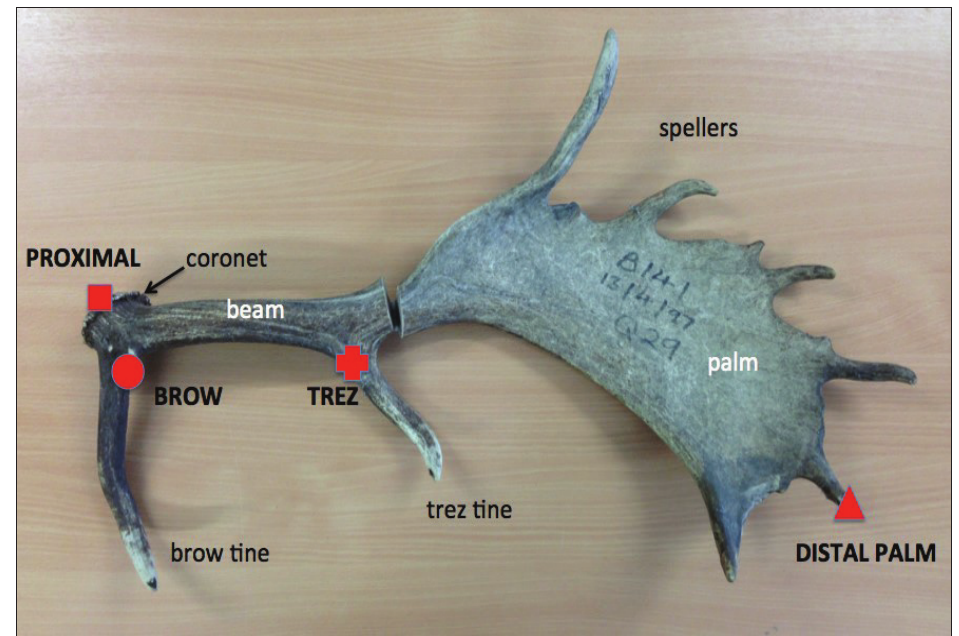
Figure 1: Sample locations on